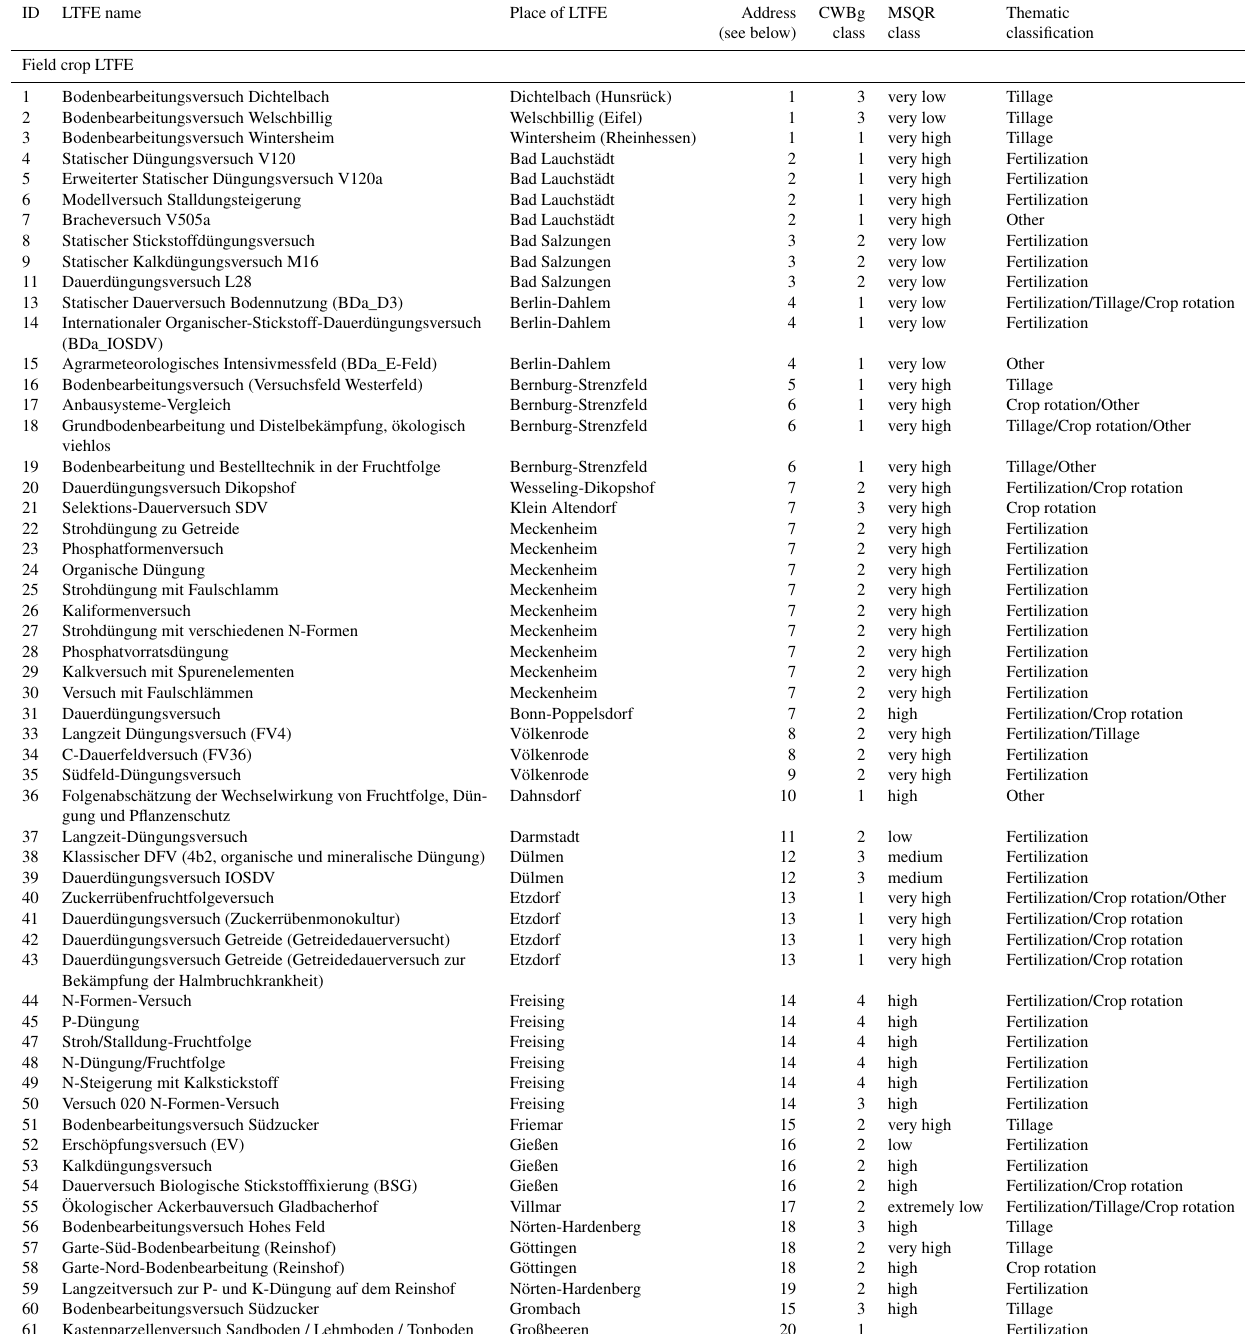
Table A1. IDs of all long-term field experiments, their original name, their location, their CWBg class (1 May to 31 October), their MSQR class and their thematic classification. The institution address is indicated by a number and given below the table. More details about the LTFEs can be found in the complete dataset (Grosse and Hierold,